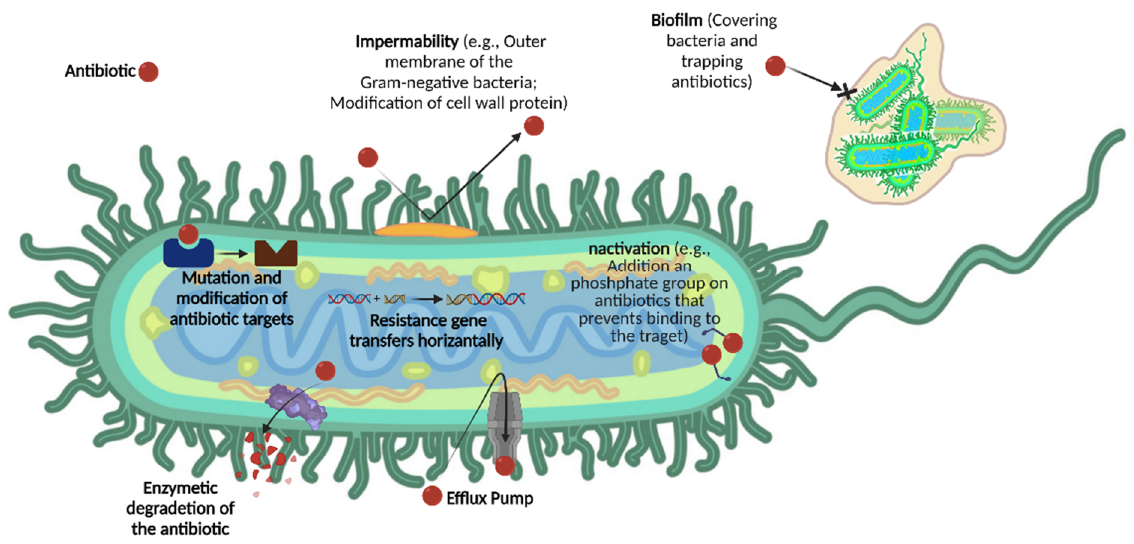
Figure 1. The seven most common mechanisms of antimicrobial resistance (AMR).